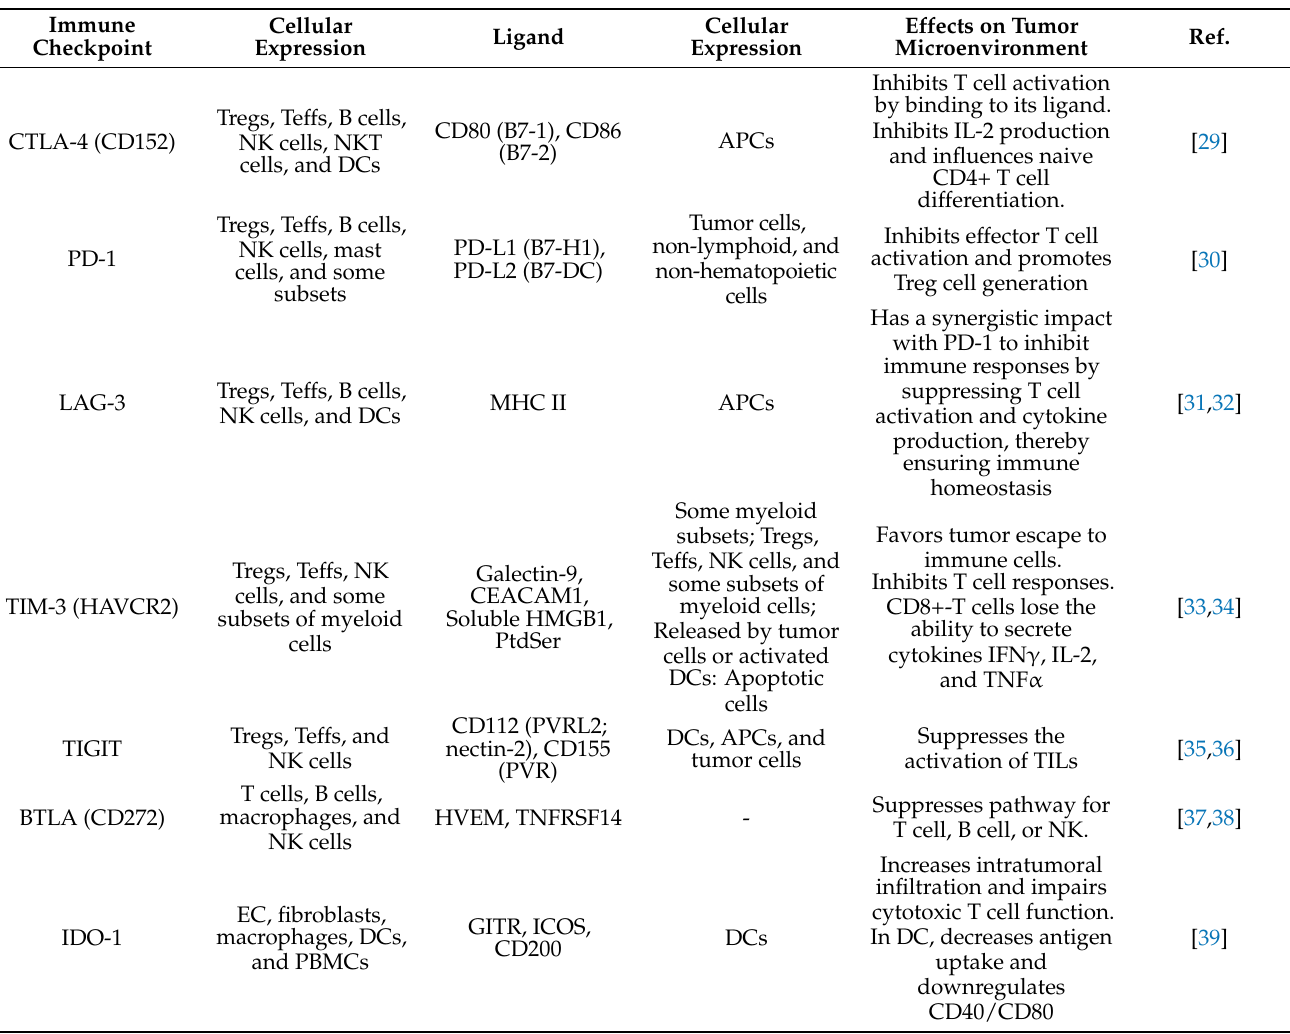
Table 1. The expression pattern of membrane bound isoform of immune checkpoints (ICs) and their effects on tumor microenvironment. Immune Cellular Cellular Effects on Tumor Ligand Checkpoint Expression Expression Microenvironment